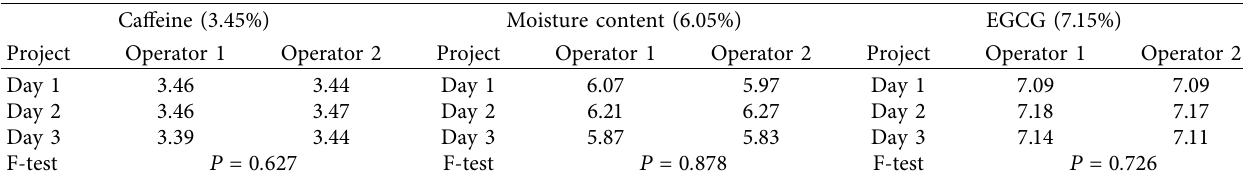
Table 6: Results from intermediate precision